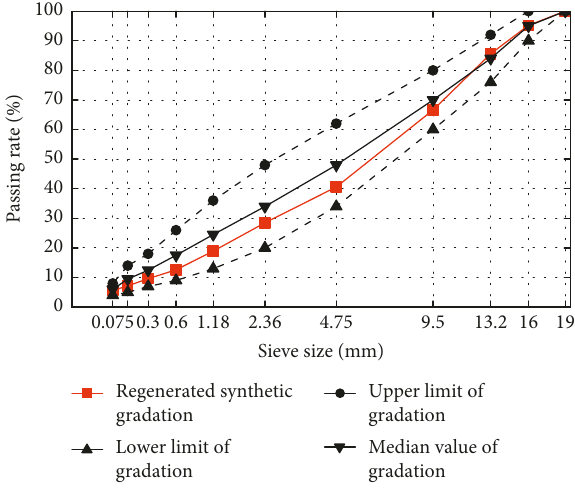
Figure 1: Synthetic gradation curve of AC-16.